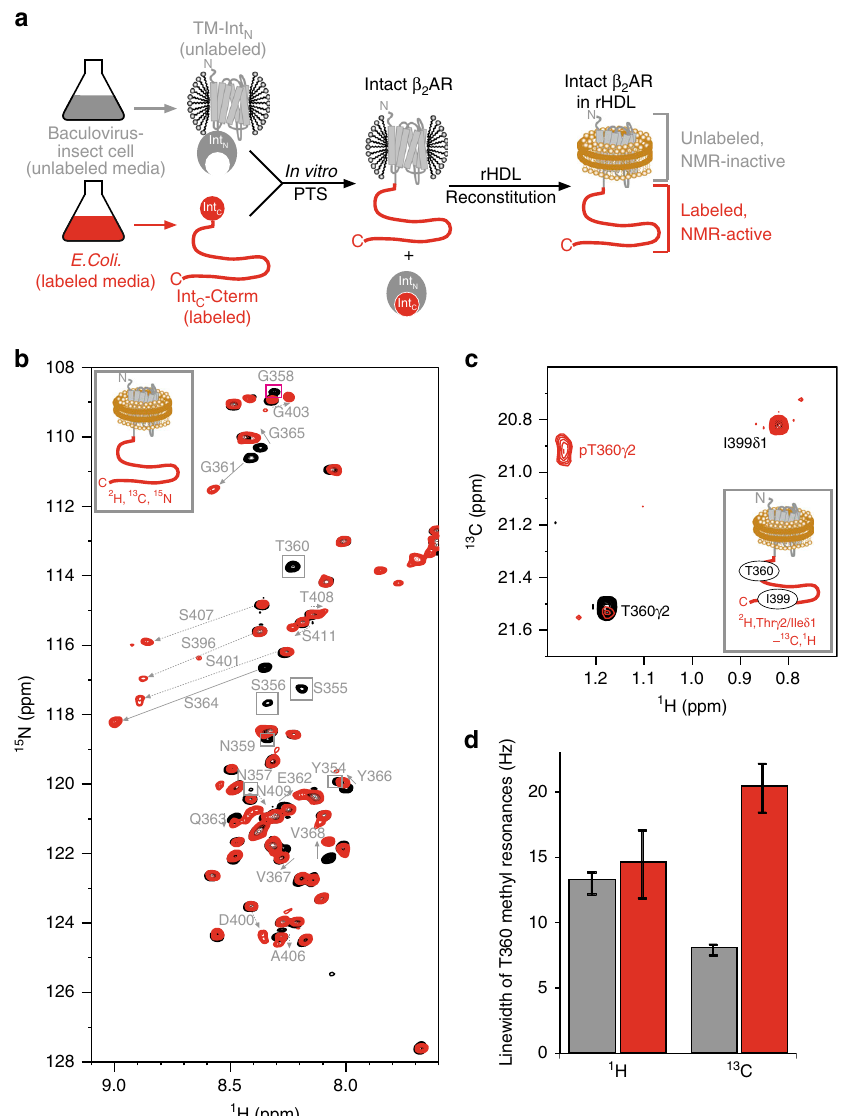
Fig. 2 NMR spectra of the C-terminal region of the segmentally labeled β 2 AR. a Schematic diagram of the preparation of segmentally labeled β 2 AR. b Overlay of the 1 H- 15 N HSQC spectra of the unphosphorylated (black) and phosphorylated (red) {Cterm- [ 2 H, 13 C, 15 N]} β 2 AR in rHDLs. Resonances that were not observed in the phosphorylated β 2 AR are indicated with boxes, and resonances that exhibited different chemical shifts between the unphosphorylated and phosphorylated spectra are indicated with arrows. c Overlay of the 1 H- 13 C HMQC spectra of {Cterm- [ 2 H, Thr γ 2-, Ile δ 1-[ 13 C, 1 H]} 1 H and 13 C linewidths of the T360 methyl signals of the unphosphorylated (gray bars) and phosphorylated (red bars) β β 2 AR in rHDLs. d linewidths were calculated by fi tting the Lorentzian function to the signals using Topspin 3.1. The error bars indicate the standard errors of the fi